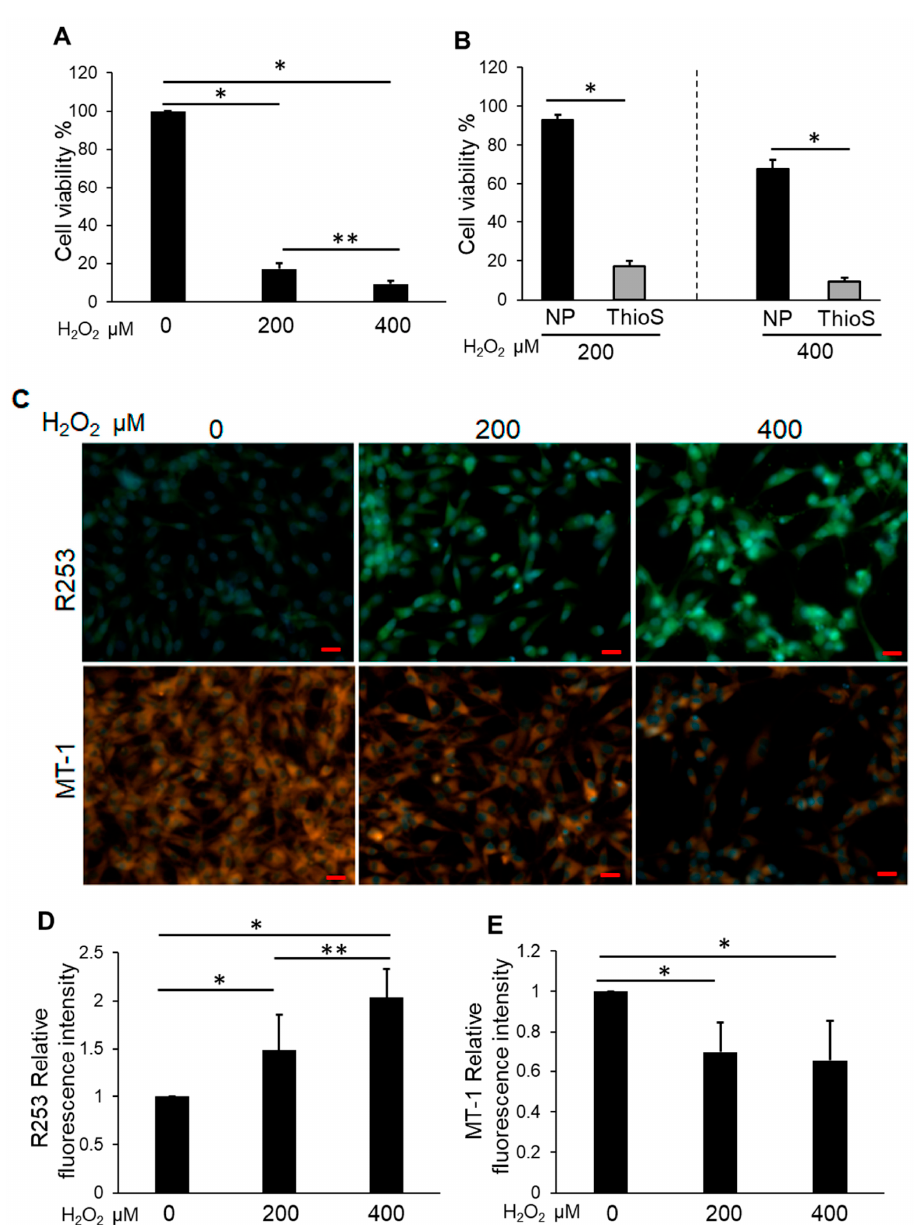
Figure 5. ( A ) Cell viability of thioflavin-S (ThioS)-treated NP cells under H 2 O 2 treatment. NP cells were treated with 100 µ M thioflavin-S for 16 h and then fed fresh DMEM without or with between 200 and 400 μ M H 2 O 2 for 24 h. Data are the means ± SD n = 4, * p < 0.05, ** p < 0.05. ( B ) Comparison of the cell viability of NP cells (NP) and thioflavin-S-treated NP cells (ThioS) treated with H 2 O 2 for 24 h. Data are the means ± SD n = 4, * p < 0.05. ( C ) The upper row of the figure represents ROS production, which was monitored using R253 (green) and the lower row is the mitochondrial membrane potential, which was monitored using MT-1 (orange). The nucleus was detected by Hoechst 33342 reagent (blue). The detection of ROS production increased under H 2 O 2 treatment, and the detection of MT-1 decreased. Scale bars = 20 µ m. ( D ) Quantitative data of ROS production (R253) in thioflavin-S-treated NP cells. Data are the means ± SD n = 3, * p < 0.05, ** p < 0.05. ( E ) Quantitative data of the mitochondrial membrane potential (MT-1) in thioflavin-S-treated NP cells. Data are the means ± SD n = 3, * p < 0.05.